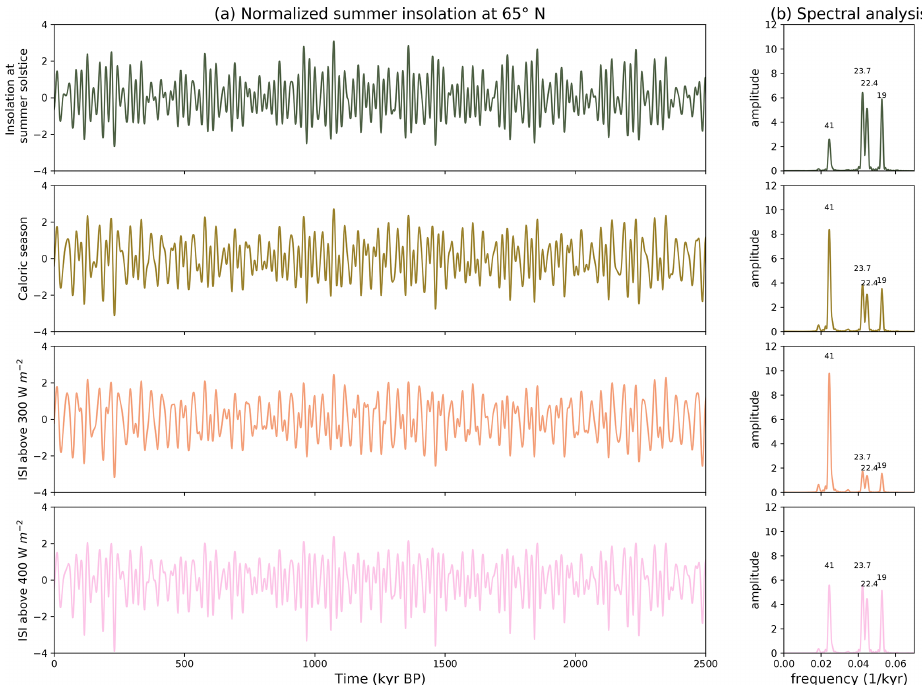
Figure 1. (a) The four different summer insolation forcings at 65 ◦ N (summer solstice, caloric season, ISI above 300Wm − 2 and ISI above 400Wm − 2 ) displayed over the Quaternary. The insolation forcings are centred and normalized by their standard deviation. (b) Correspond- ing spectral analysis over the Quaternary, normalized by standard